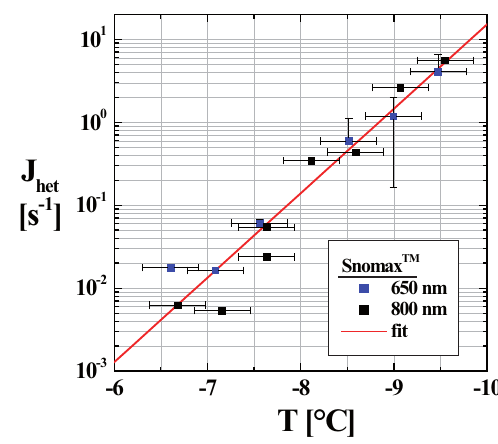
Fig. 7. Heterogeneous ice nucleation rate of single INA protein complexes J het as function of temperature T derived for 650nm and 800nm